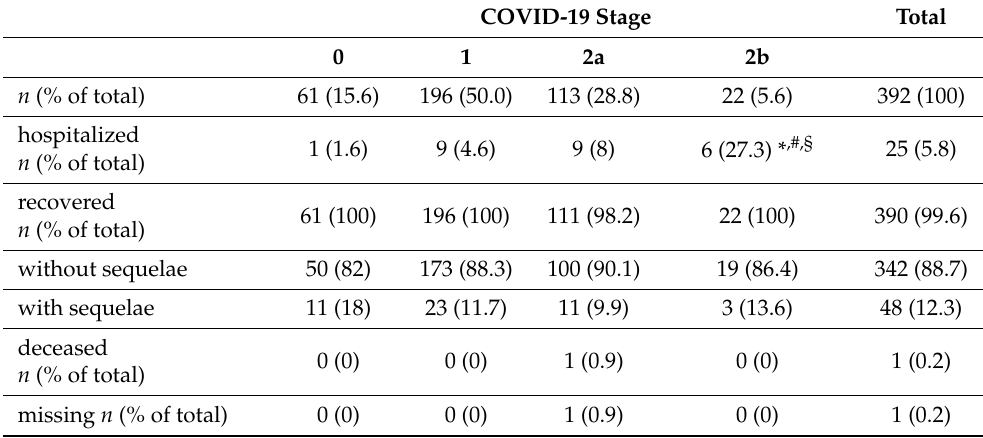
Table 3. Outcomes of COVID-19 patients included in the study according to disease stage when patients were taken care of.